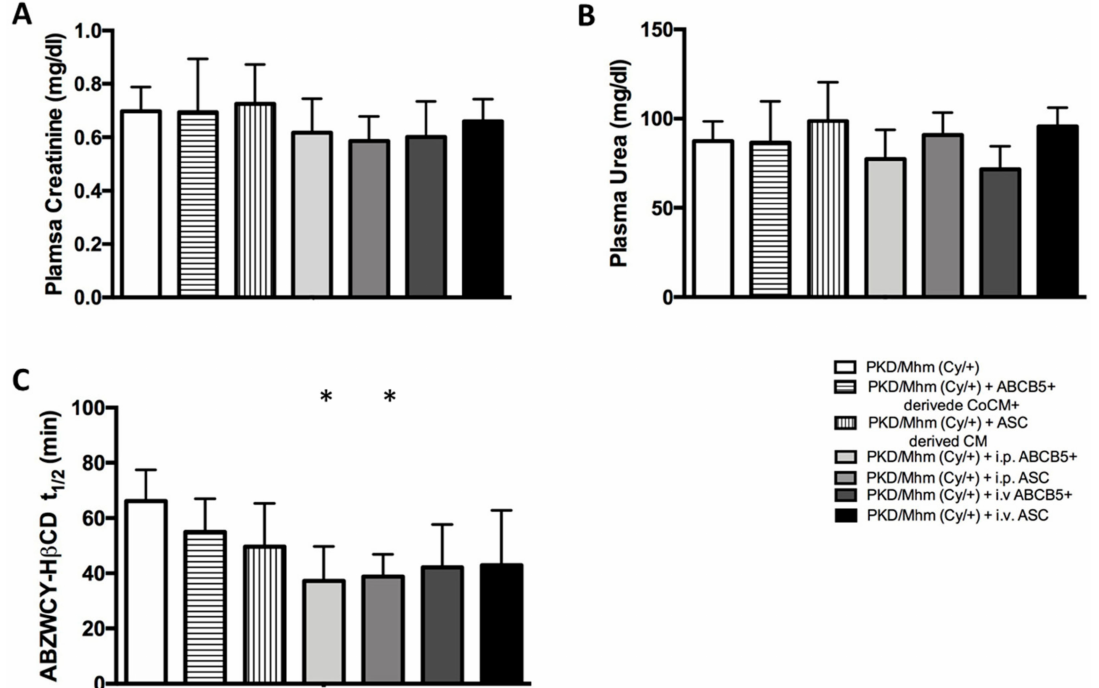
Figure 5. Effect of different treatments on renal function parameters in the PKD/Mhm (Cy/+) model (n = 6 in each group). Changes in plasma creatinine ( A ) and urea ( B ) concentrations, and in ABZWCY-H β CD half-life (t 1/2 ) ( C ). Histograms show means ± Std.Dev. * p <